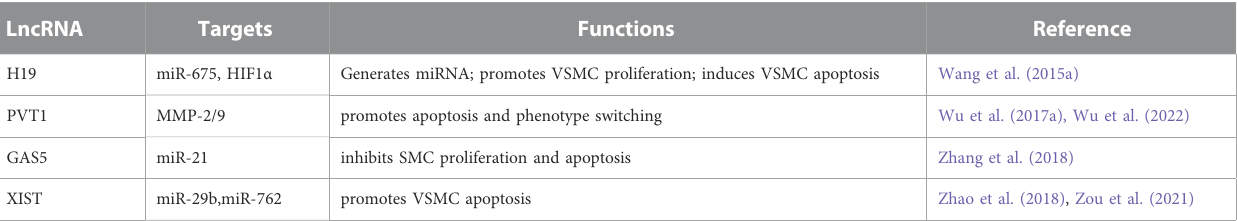
TABLE 1 Summary of lncRNAs regulating pathophysiology of AAAs.